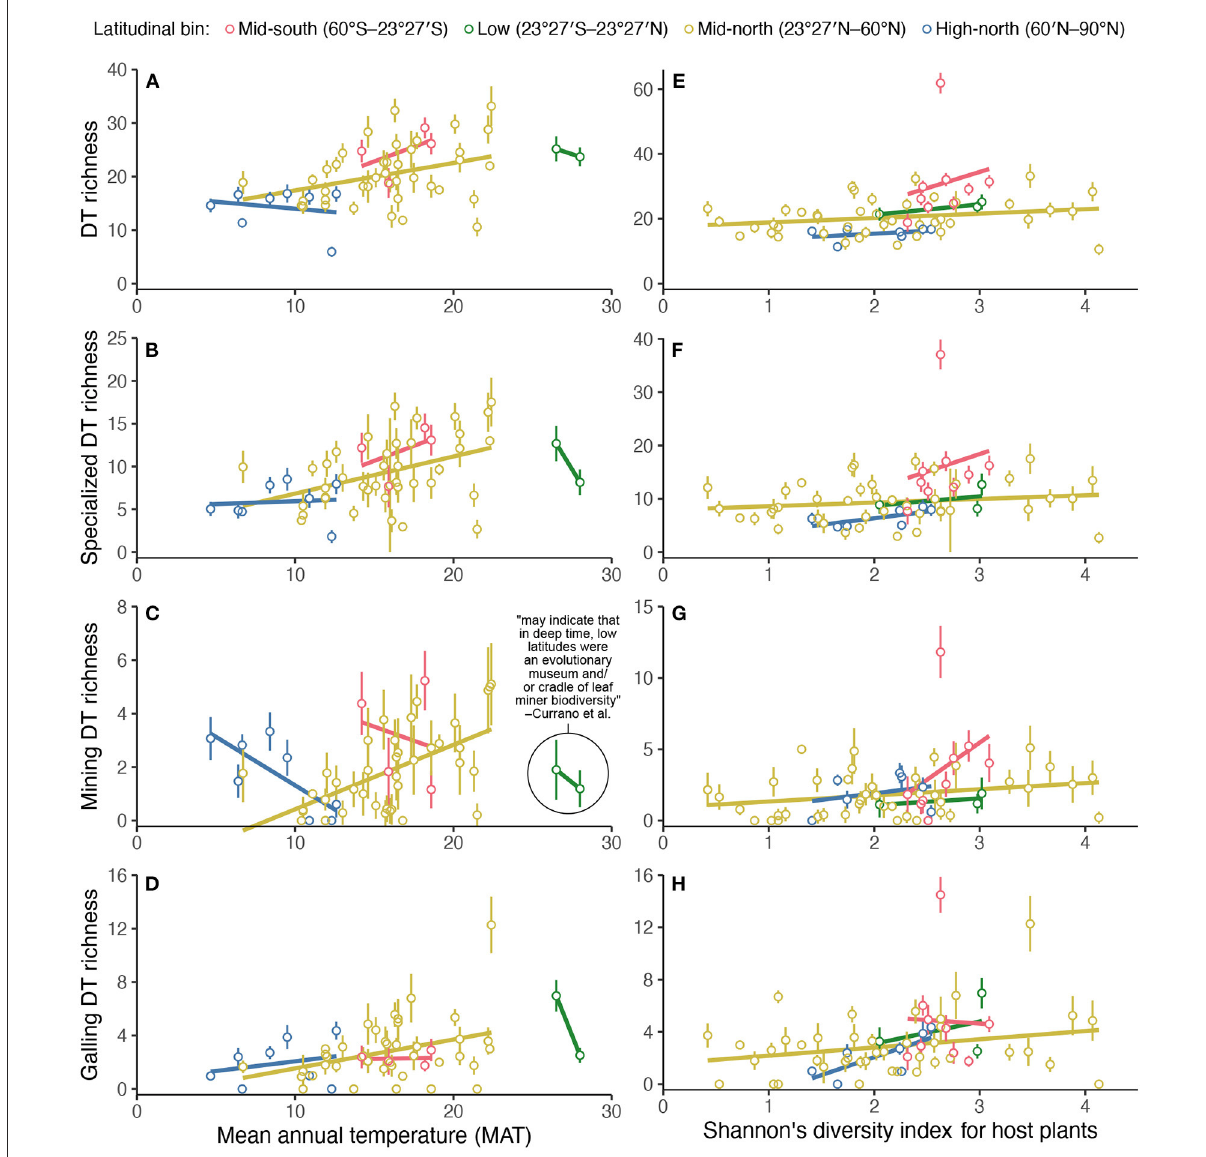
FIGURE5 The relationship of damage type (DT) diversity at each assemblage in Currano et al. (2021)’s compilation, rarefied to 300 leaves (y-axis), to mean annual temperature (left) (A–D) and Shannon’s diversity index for host plants at each assemblage (right) (E–H) . The color scheme is the “bright” qualitative color scheme from Paul Tol’s notes